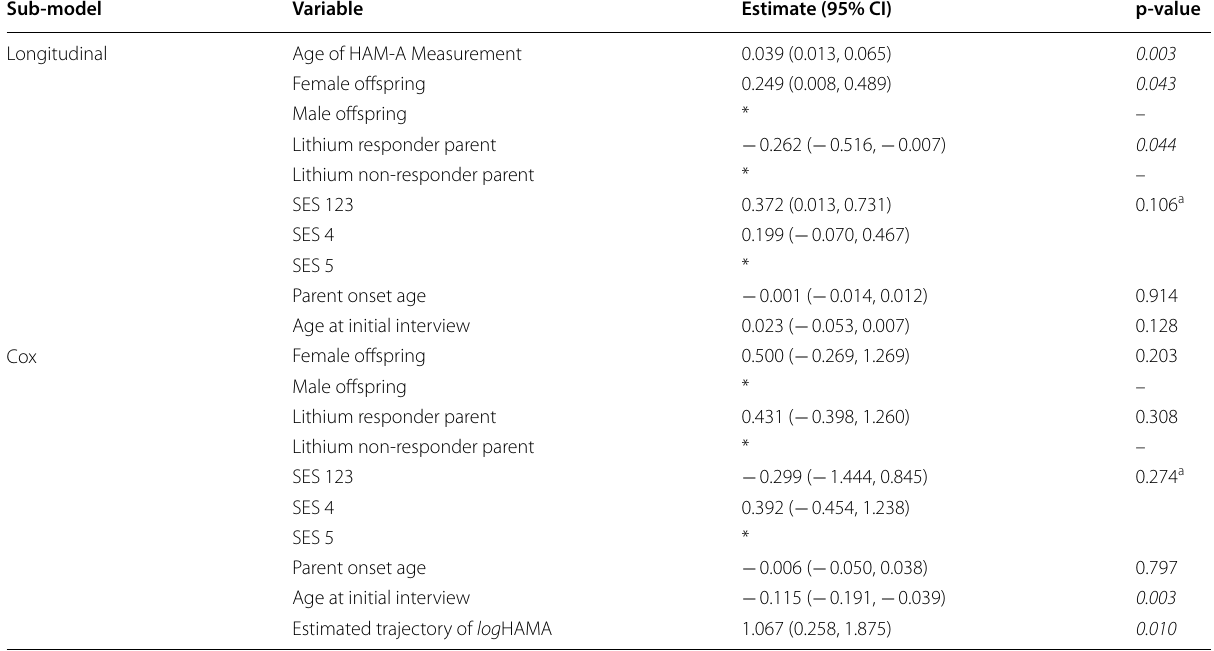
156) with 95% confidence interval =